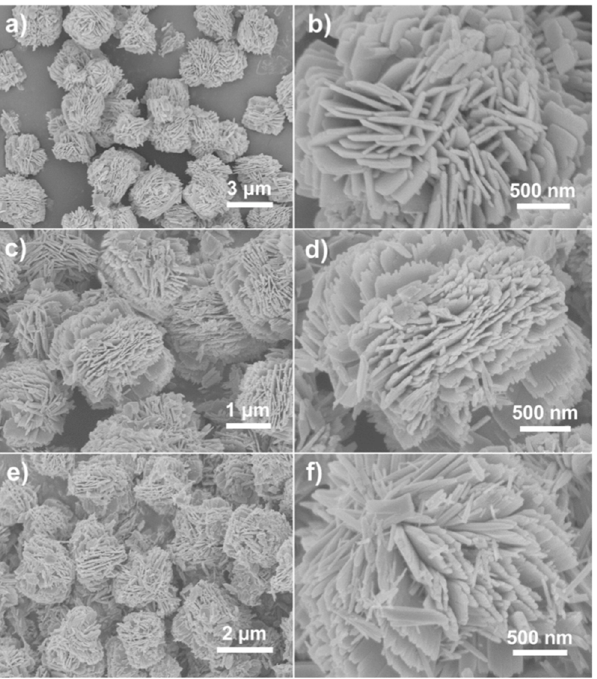
Figure 14. SEM micrographs of directly hydrothermal synthesized ZnO nanoflower ( a , b ), and low ( c , d ) and high ( e , f ) ultrasonic treatment synthesized ZnO nanoflowers. Reprinted with permission from [62]. Copyright (2020) Elsevier B.V.